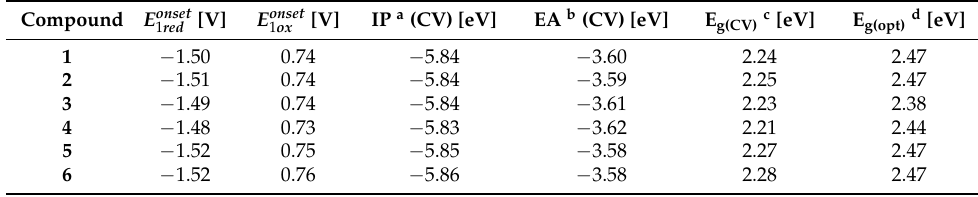
Table 1. Electrochemical data measured by cyclic